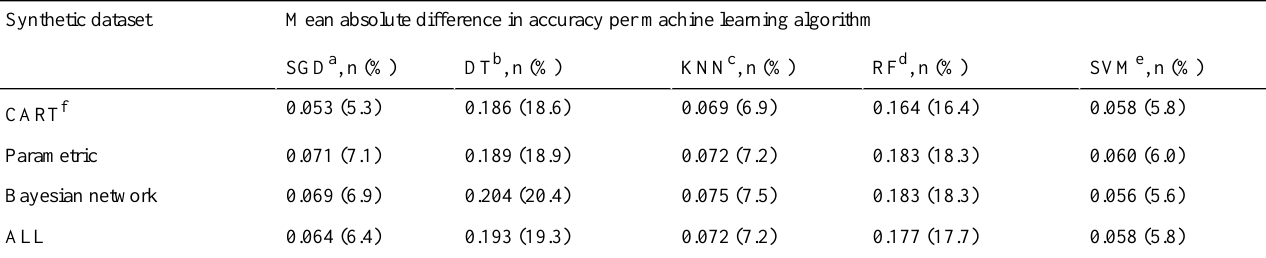
Table 4. Mean absolute difference in accuracy for each machine learning model and synthetic data type. Mean absolute difference in accuracy per machine learning algorithmSynthetic dataset